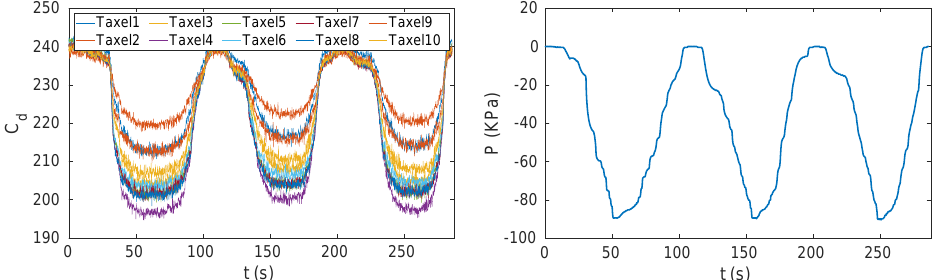
Figure 6. Capacitances measured by one triangle (i.e., 10 taxels) and pressures measured by the pressure sensor during the vacuum bag experiment that consisted of three cycles of pressure reduction and increase.